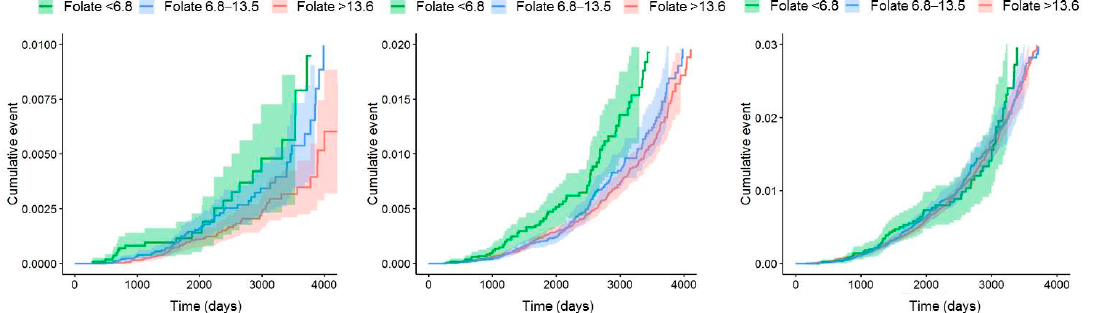
Figure 2. Cumulative event curves for peripheral neuropathy according to serum folate concentrations and age, using 95% Kaplan–Meier confidence interval (CI). Time in days (d).